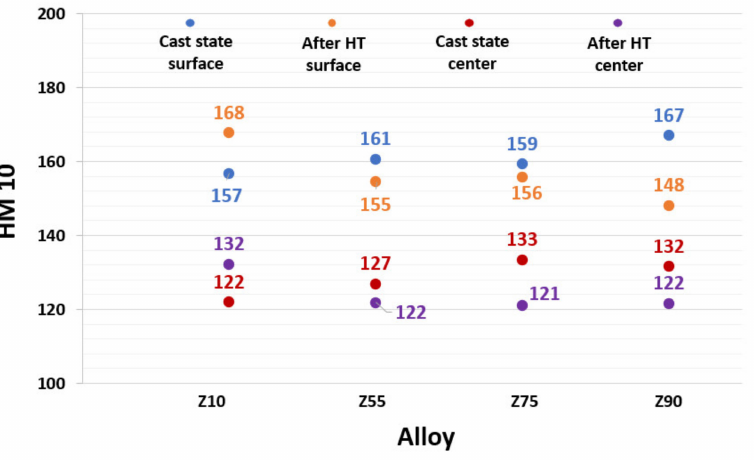
Figure 10. Dependence of the primary α -phase microhardness of AlSi9Cu3 alloy on the amount of returnable material in the batch and the measuring position on the